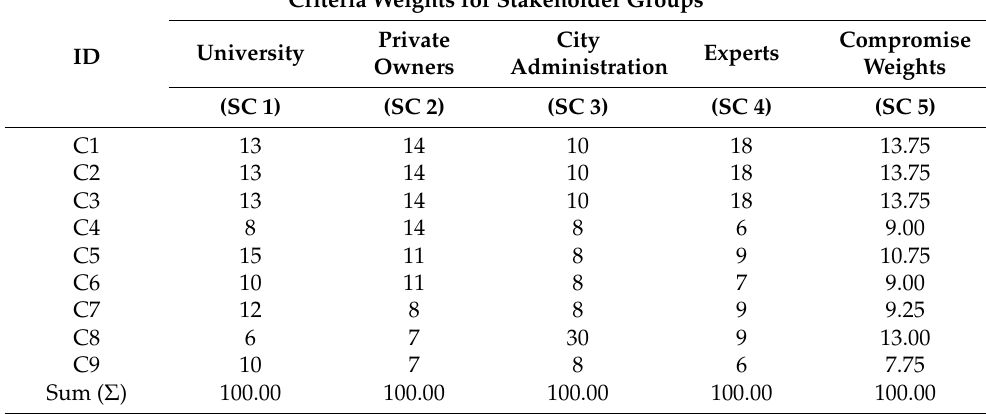
Table 6. Criteria weights for four scenarios obtained by the AHP method for each group of stake- holders and weights of the fifth compromise